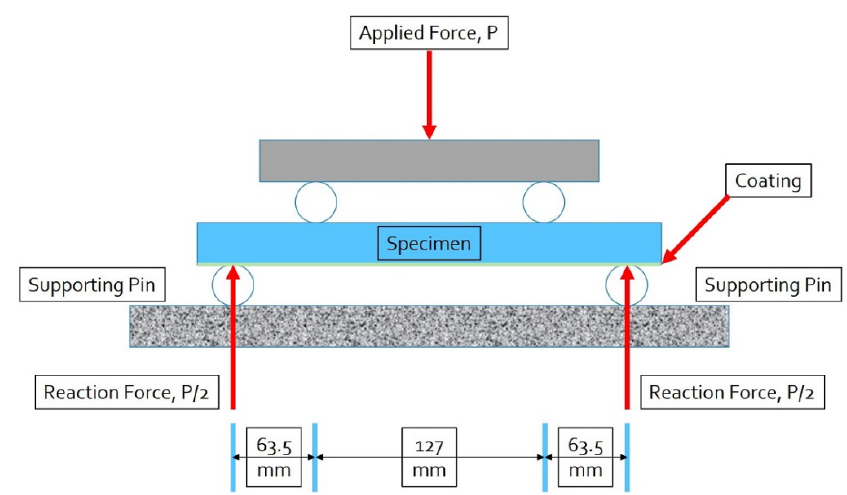
Figure 3. Schematic diagram of four-point bending test.